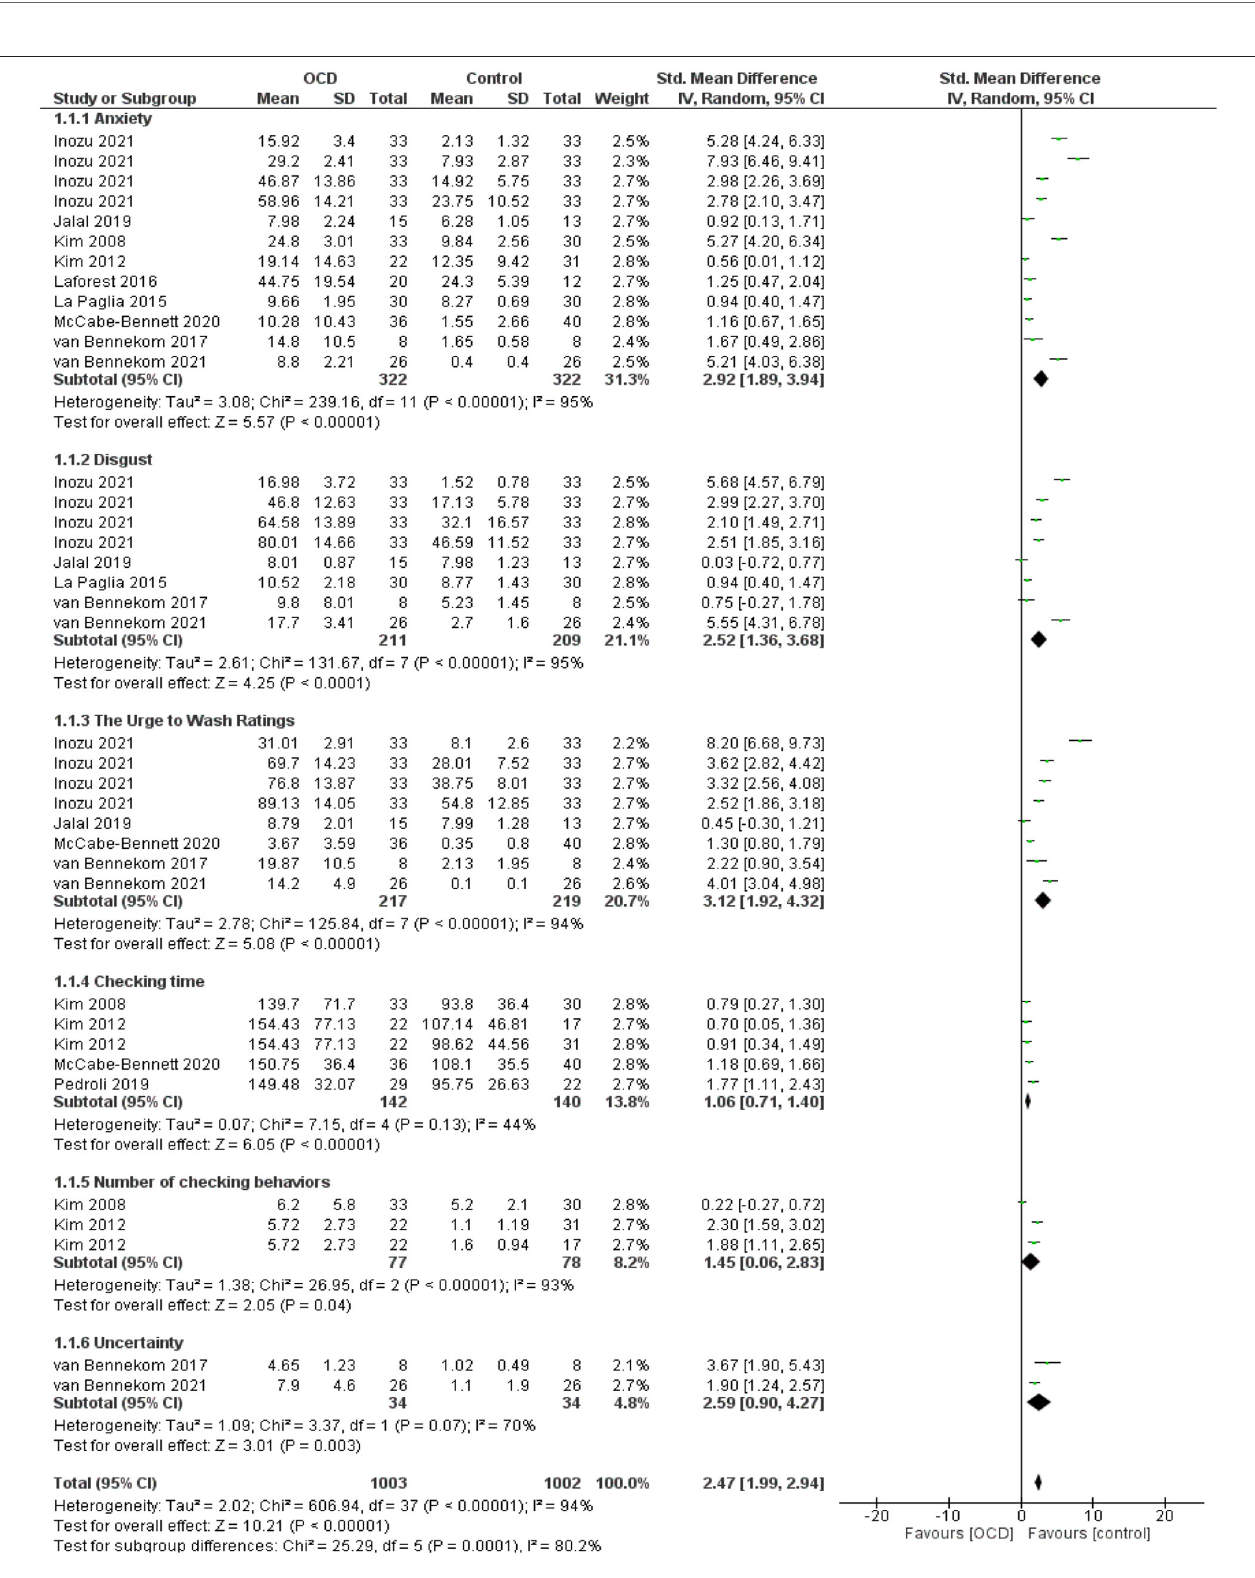
FIGURE 3 | Forest plots for OCD symptoms. The green blocks indicate the weight assigned to the study, the horizontal line depicts the CI, and the black rhombus shows the overall result. IV, inverse variance; Std, standard.